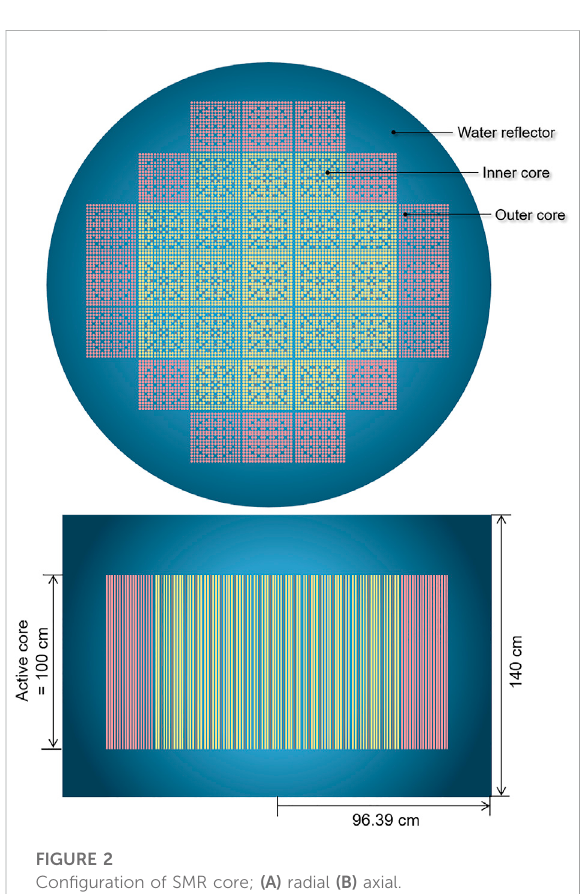
FIGURE 2 Con fi guration of SMR core; (A) radial (B)